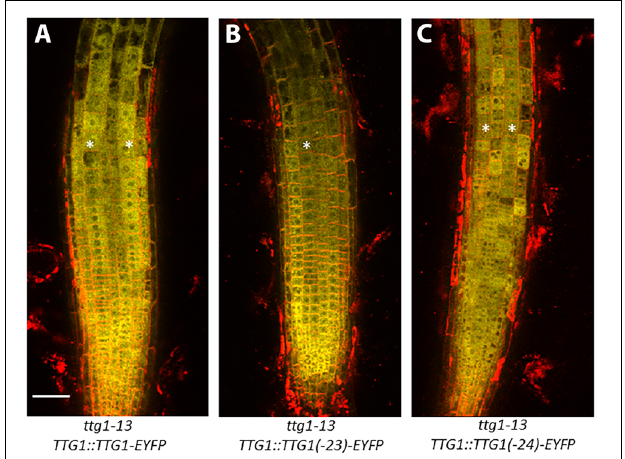
FIGURE 8 | Accumulation of TTG1-EYFP fusion proteins in ttg1-13 seedling roots bearing the (A) TTG1:TTG1 (WT) -EYFP, (B) TTG1:TTG1 ( ttg1-23 ) -EYFP , or (C) TTG1:TTG1 ( ttg1-24 ) -EYFP transgene. White stars mark the H-position epidermal cell files. The red color represents propidium iodide and the yellow color represents YFP. Representative images are shown from the analysis of at least 3 independent single-insertion lines for each transgenic experiment. Bar = 50 µ